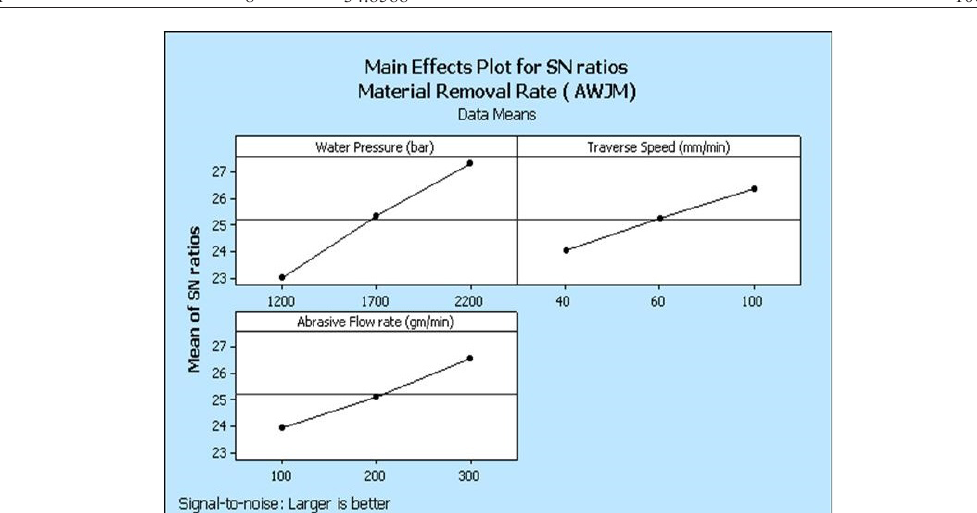
Figure 7. Main effects plot for SN ratios - MRR-AWJM.